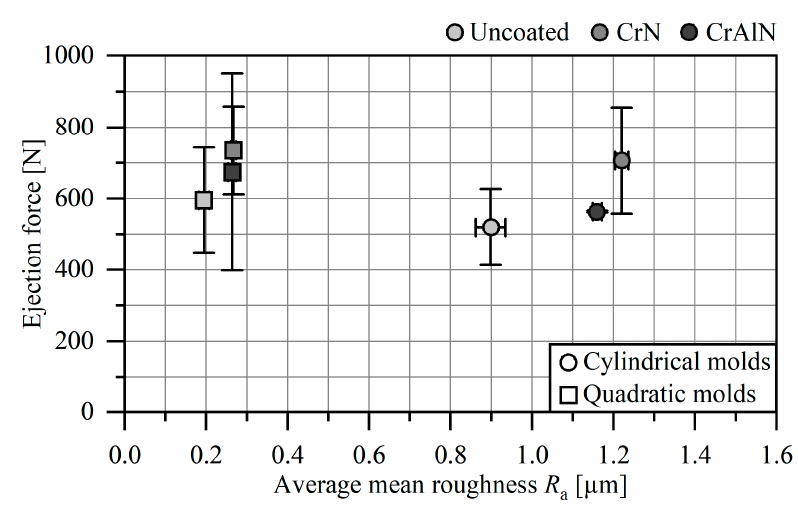
Figure 9. Ejection forces plotted against the average mean roughness R a .